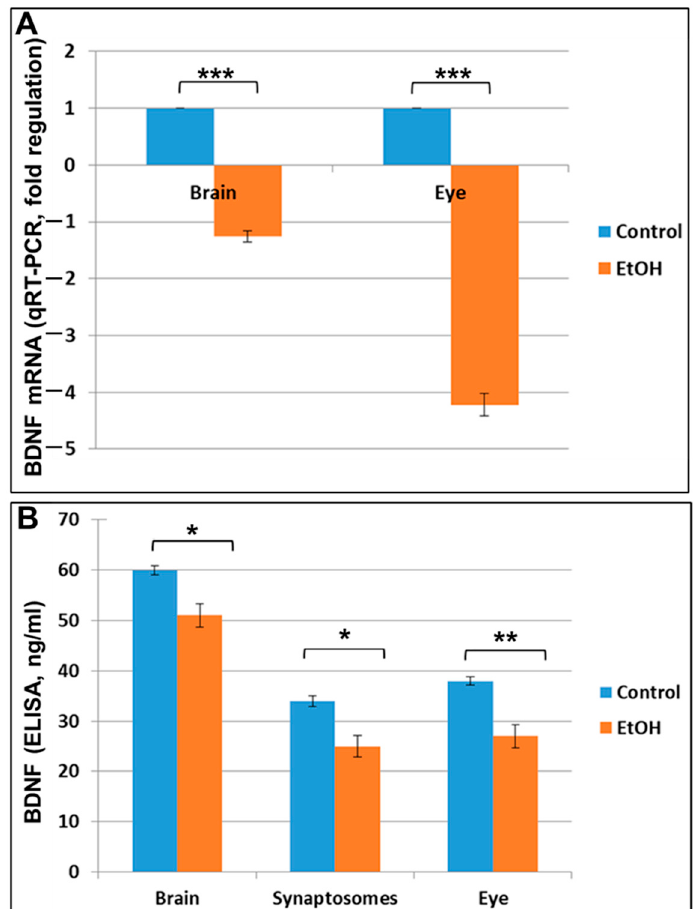
Figure 3. Prenatal EtOH exposure inhibits BDNF mRNA and protein expression in fetal eye, brain and synaptosomes in EtOH-exposed samples compared to unexposed controls. ( A ) Prenatal EtOH exposure was associated with a 1.26-fold down-regulation of BDNF mRNA expression in brain, and a 4.22-fold down-regulation in eye (Control n = 10 and EtOH n = 10, each representing the average of triplicate determinations). There was a 2-fold decrease in BDNF mRNA expression in eye tissues compared to brain tissues. ( B ) Expression of BDNF protein in brain, synaptosomes and eye was assayed by ELISA (see Methods). Each assay was performed in triplicate and error bars indicate standard deviation. Significance levels are based on the number of fetuses, not the number of measurements. * p < 0.05; ** p < 0.01, *** p < 0.001.